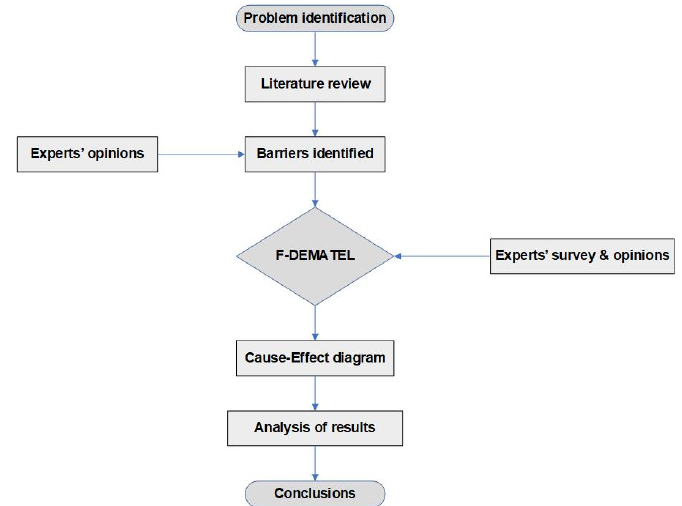
Fig. 1. Flow chart of the research